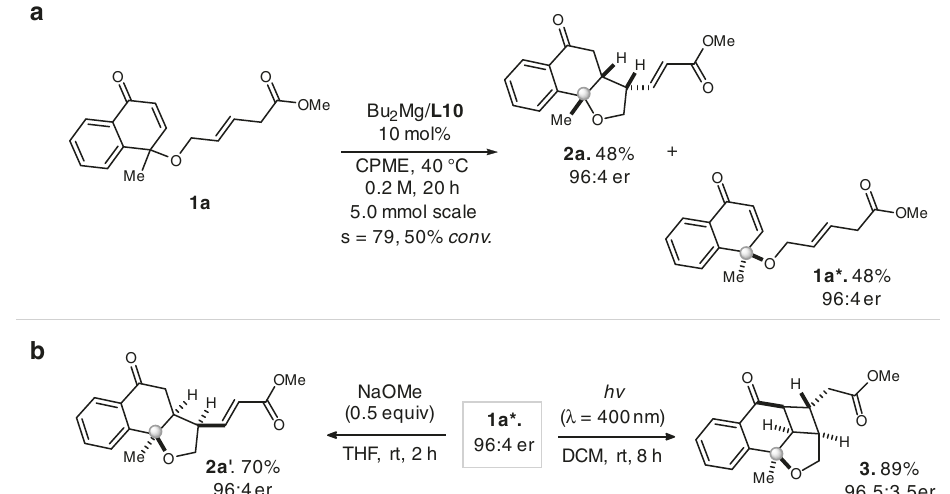
Fig. 6 Gram scale trial and related transformation of 1a*. a Gram scale experiments of the KR process. b Transformations of the isolated chiral allylic ester 1a* .